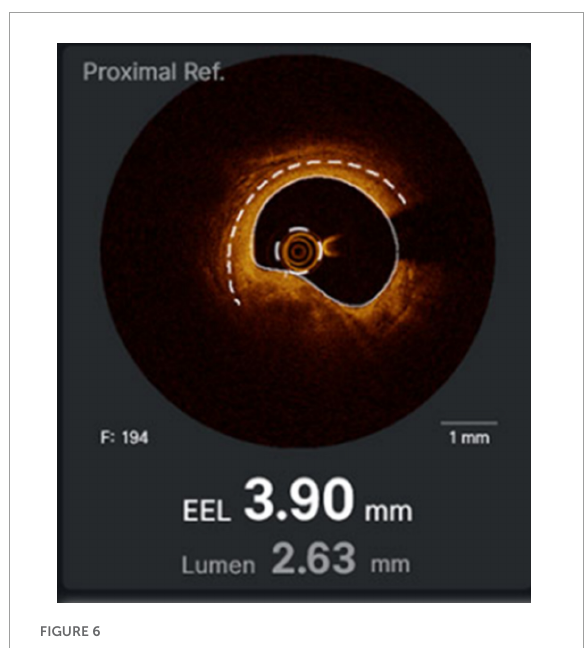
FIGURE6 Artificial intelligence-driven stent/vessel